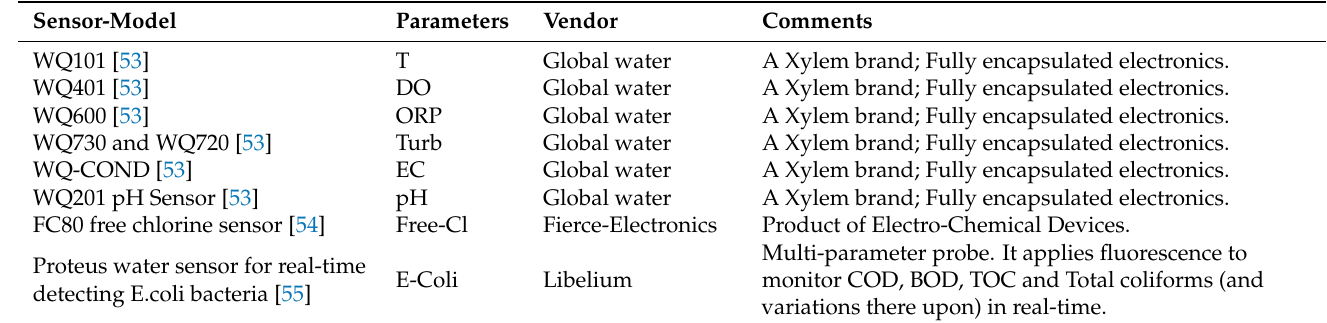
Table 4. WQM sensors for